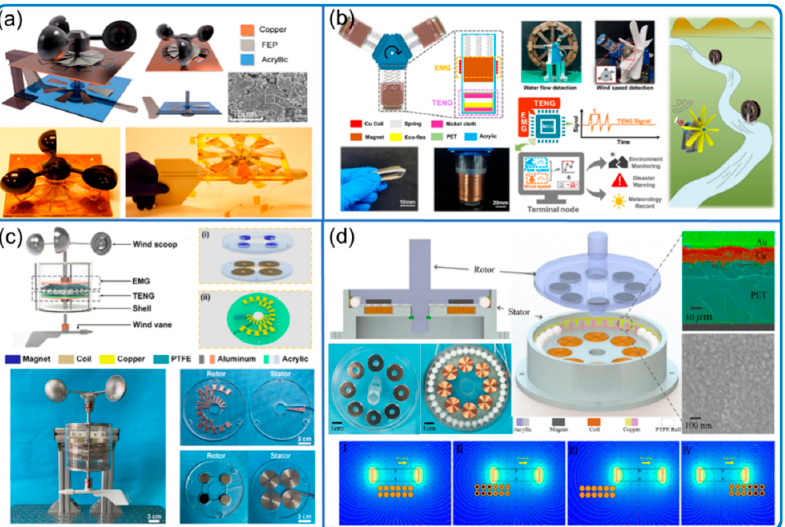
Figure 3. Sensing of wind speed with direction: conventional wind cups and turbine. ( a ) Soft friction system with wind vane. Reproduced with permission. Copyright 2018, American Chemical Soci- ety [18]. ( b ) Unmanned environment monitoring system. Reproduced with permission. Copyright 2021, Elsevier [21]. ( c ) Wind direction sensing with Gray code. Reproduced with permission. Copy- right 2021, American Chemical Society [19]. ( d ) Rolling mode sensor with electromagnetic generator (EMG) direction indicator. Reproduced with permission. Copyright 2020, Elsevier [20].